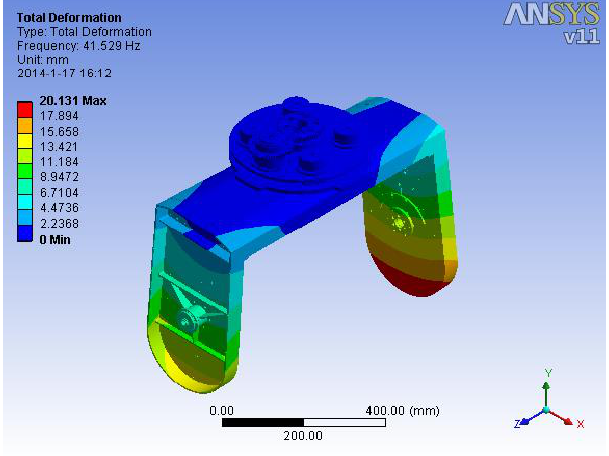
Figure 6. The first order mode of ISP